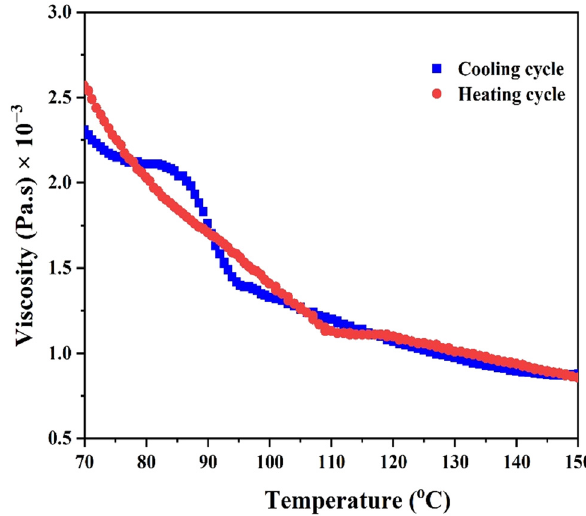
Figure 3: Hysteresis during heating and cooling cycles ( 10% LDPE in para ffi n )